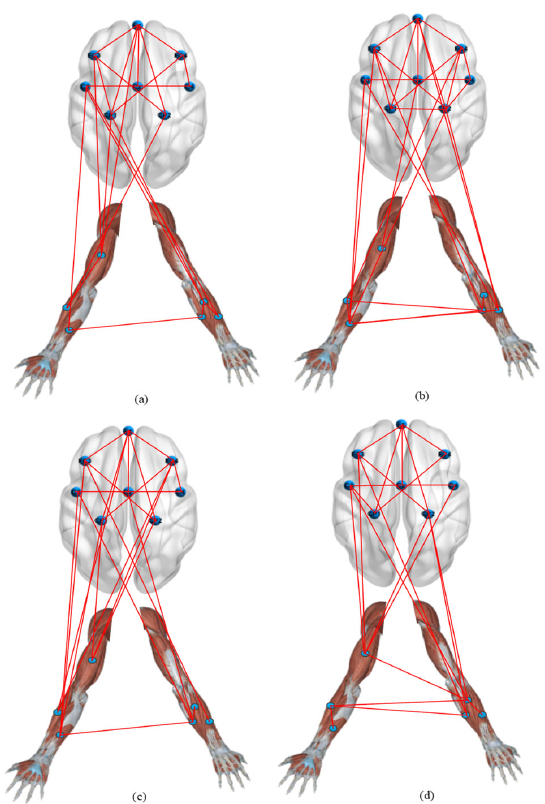
Figure 8. Corticomuscular network for different motor activities: ( a ) hand open, ( b ) hand closed, ( c ) wrist flexion, ( d ) wrist extension.